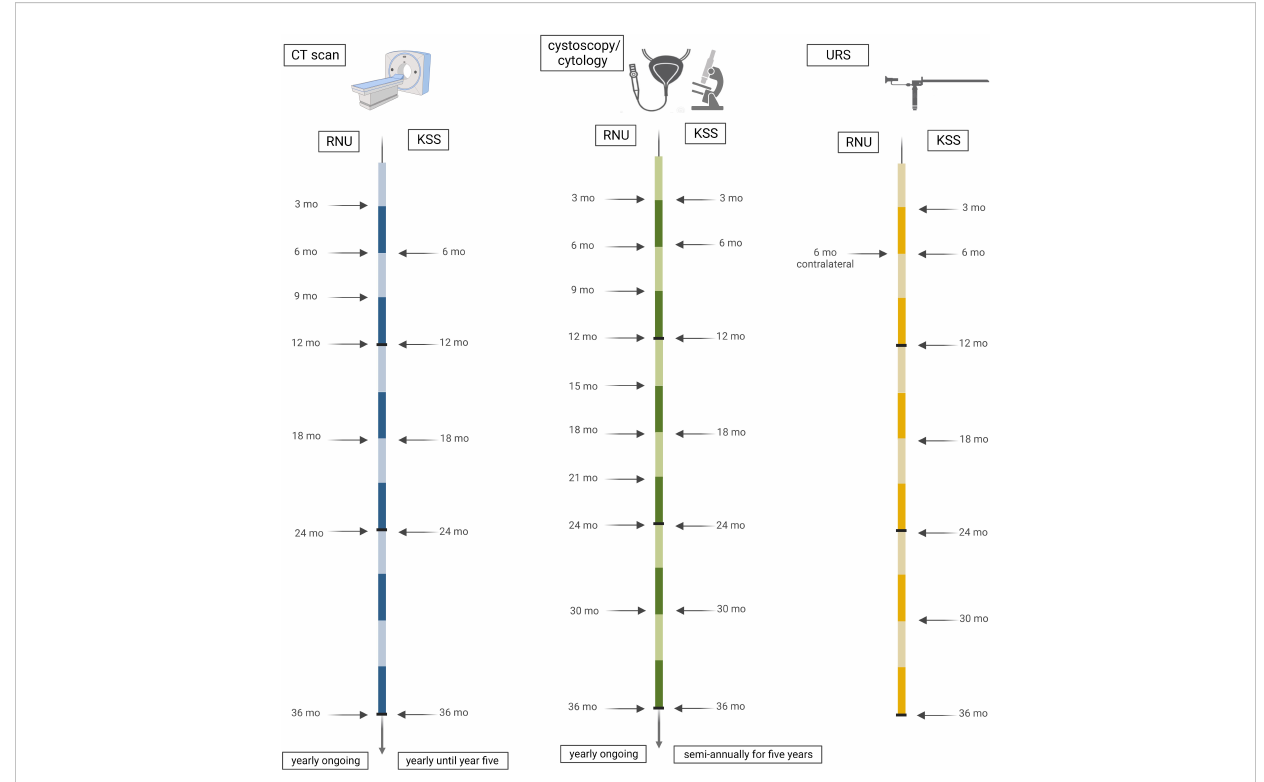
FIGURE 4 Timeline of proposed follow-up. Based on our cohort data, we suggest three-monthly cross-sectional imaging in the fi rst year after RNU, with six- month intervals in the second year and annual CT scans thereafter. After KSS, a CT should be performed every six months for two years of FU. Cystoscopy is proposed every three months for the fi rst two years after RNU, semi-annually in year three, and yearly ongoing. In KSS, cystoscopy should be performed at three and six months and semi-annually thereafter for fi ve years, and ipsilateral URS should be performed at three and six months and semi-annually thereafter for three years. Contralateral URS is recommended at six months after